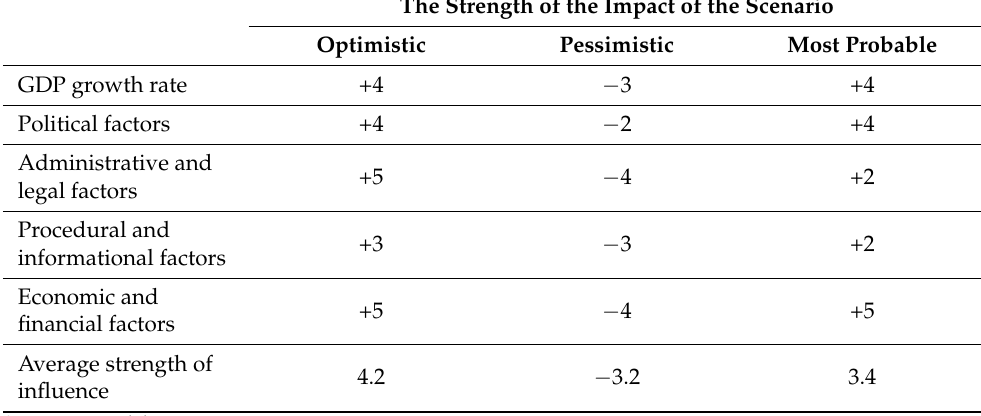
Table 4. Scenarios of changes affecting the development of